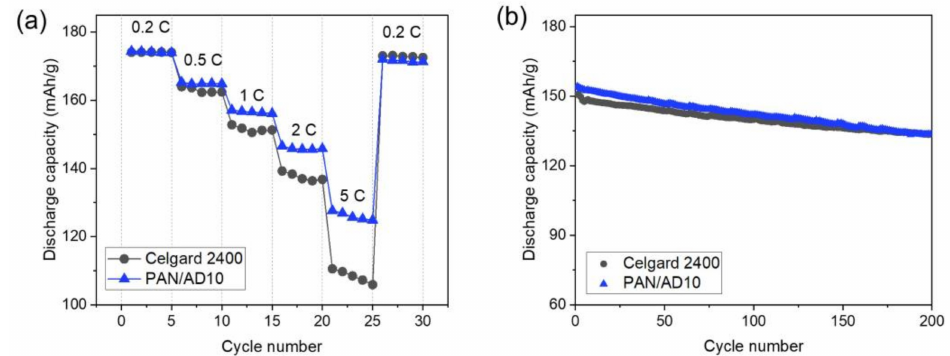
Figure 7. Comparison of ( a ) the discharge C-rate capabilities and ( b ) cycle performances (1.0 C-rate) between Celgard 2400 and PAN/AD10 (Li/membrane with LE/NCM622 cells, 3.0 − 4.2 V, room